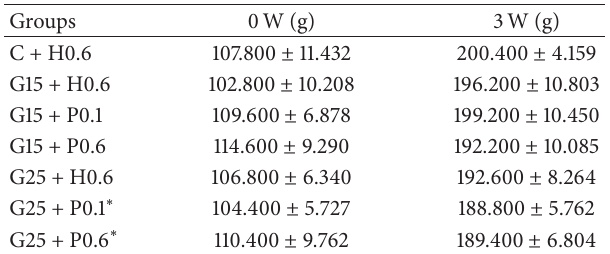
Table 1: Effect of water soluble propolis treatment on body weight in rats with